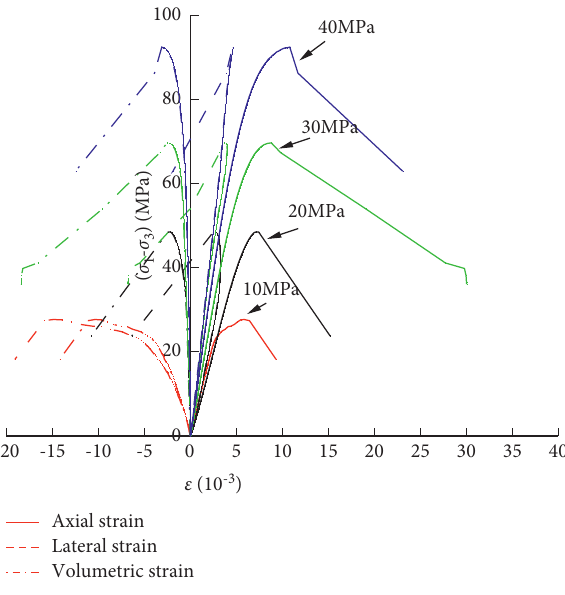
Figure 5: Total stress-strain curves with 2.31% water content in triaxial condition. Figure